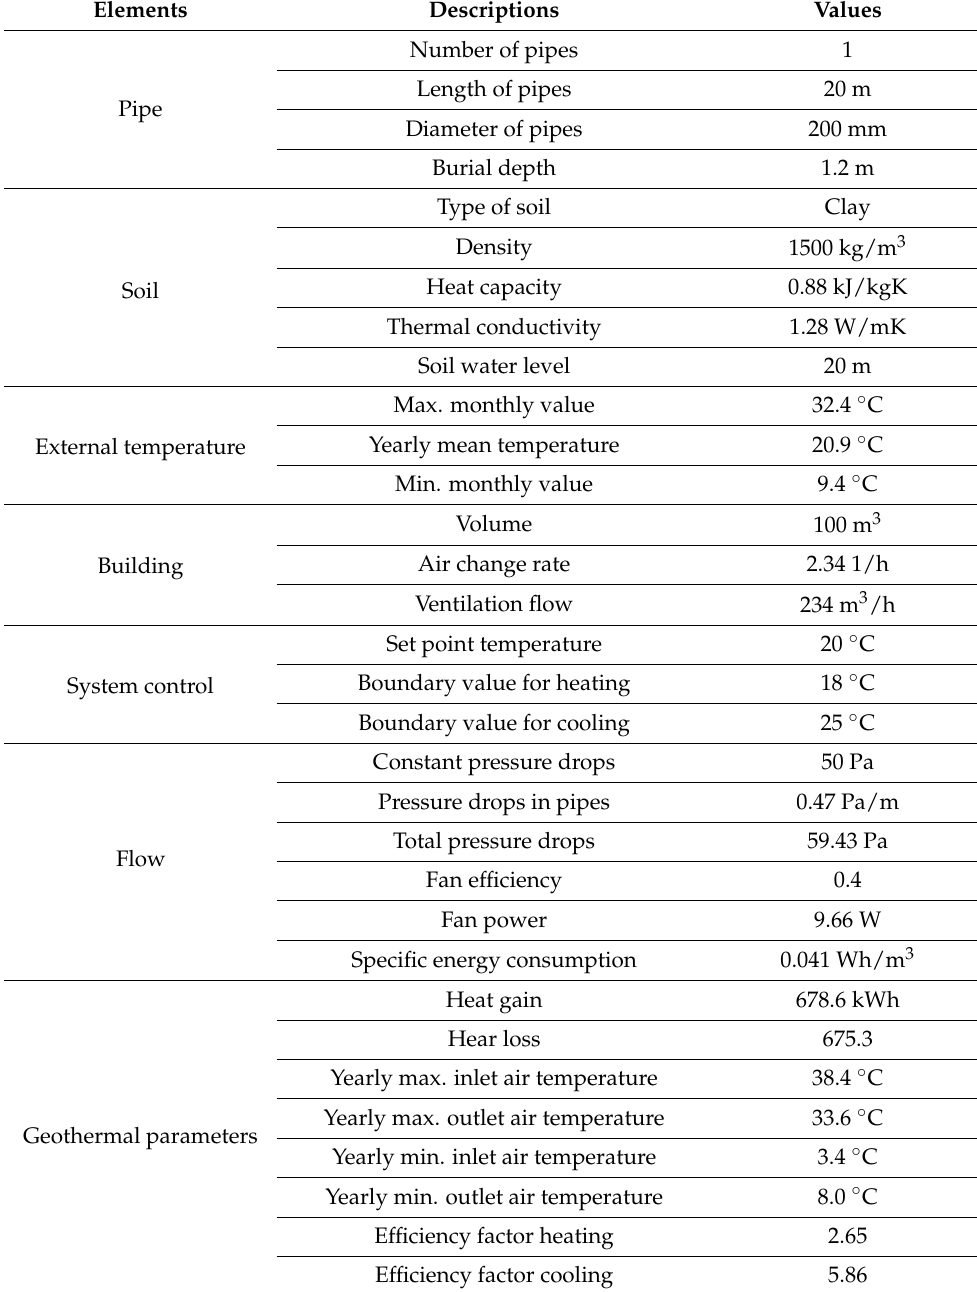
Table 2. Technical parameters of the geothermal